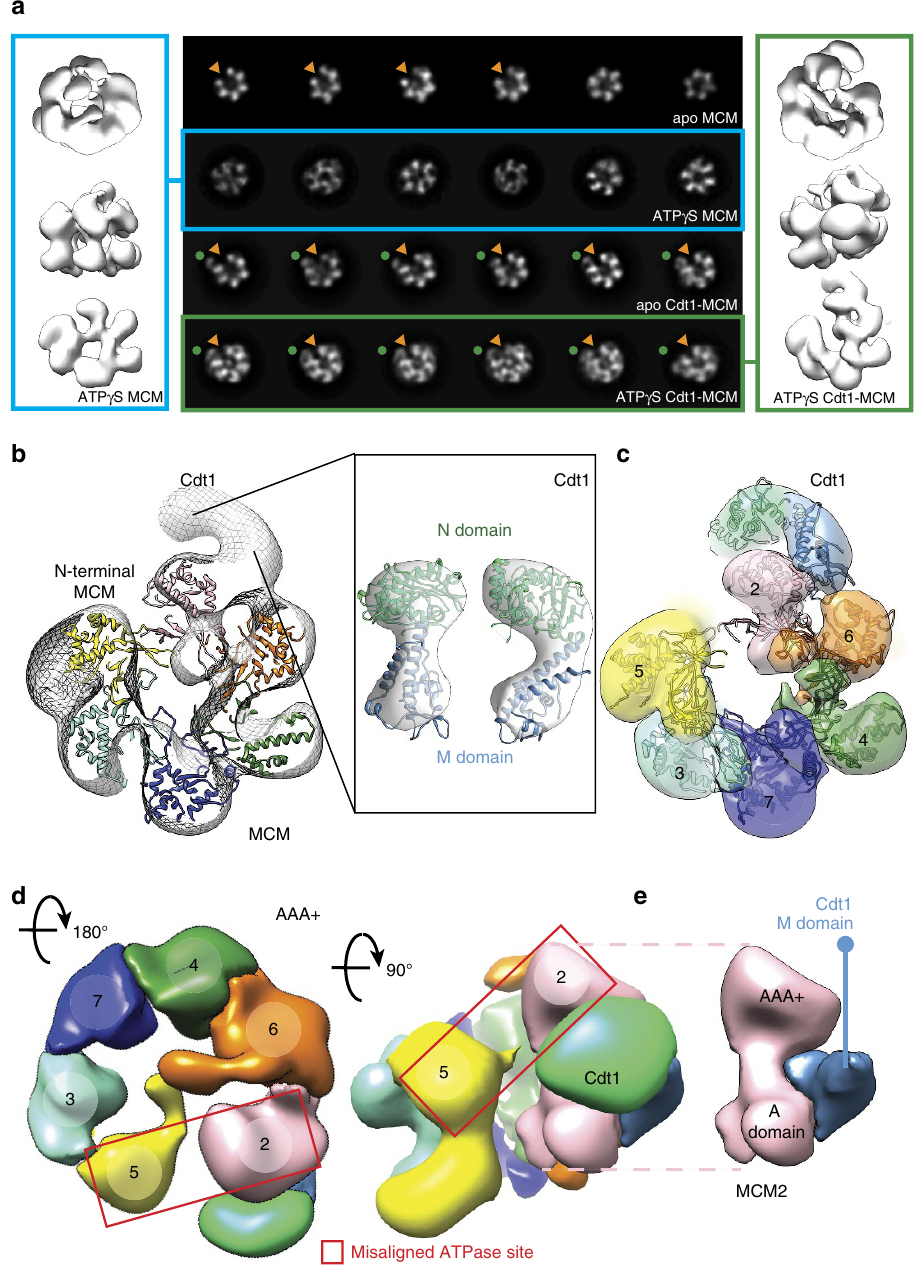
Figure 4 | Negative-stain electron microscopy of yeast MCM in the absence and presence of Cdt1. ( a ) Two-dimensional averages of free and Cdt1- associated MCM, in the apo and ATP g S-bound state (central panel). A red arrowhead points the MCM gate. ATP g S binding causes gate closure in the free MCM but not in the Ctd1-bound state. A red arrowhead points the MCM gate. Three-dimensional reconstruction of a topologically closed, ATP g S-bound MCM (left panel) and an open ATP g S-bound Cdt1–MCM (right panel). ( b ) Atomic docking of the N-terminal MCM is used to identify the register of MCM proteins. Unoccupied density on the side of the MCM ring is assigned to Cdt1. ( c ) The N-terminal domain of Cdt1 (green) is not involved in MCM interactions. The middle domain of Cdt1 contacts the A domains of Mcm2 and Mcm6. ( d ) Cdt1 binding stabilizes a left-handed spiral configuration of MCM. In this state, the Mcm2–5 ATPase interface is grossly misaligned. The middle domain of Cdt1 is sandwiched between the Mcm2 N domain and AAA þ domain. ( e ) Detail of